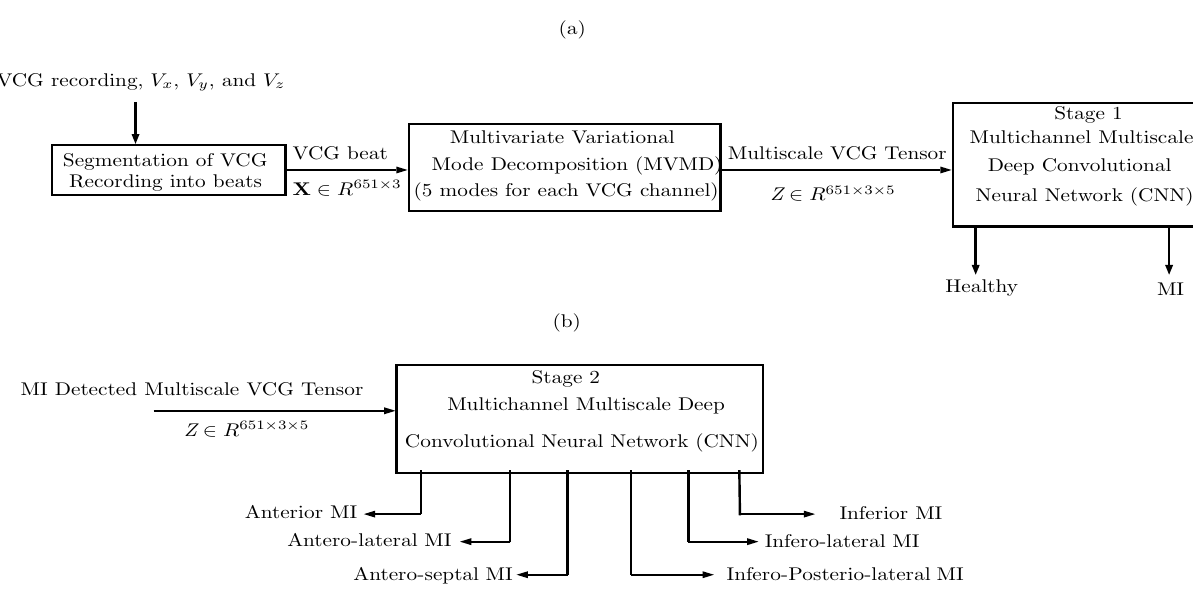
Figure 1. ( a ) Stage1 1: MI detection block using VCG signals. ( b ) Stage 2: MI localization using MI detected multi-scale VCG tensor.